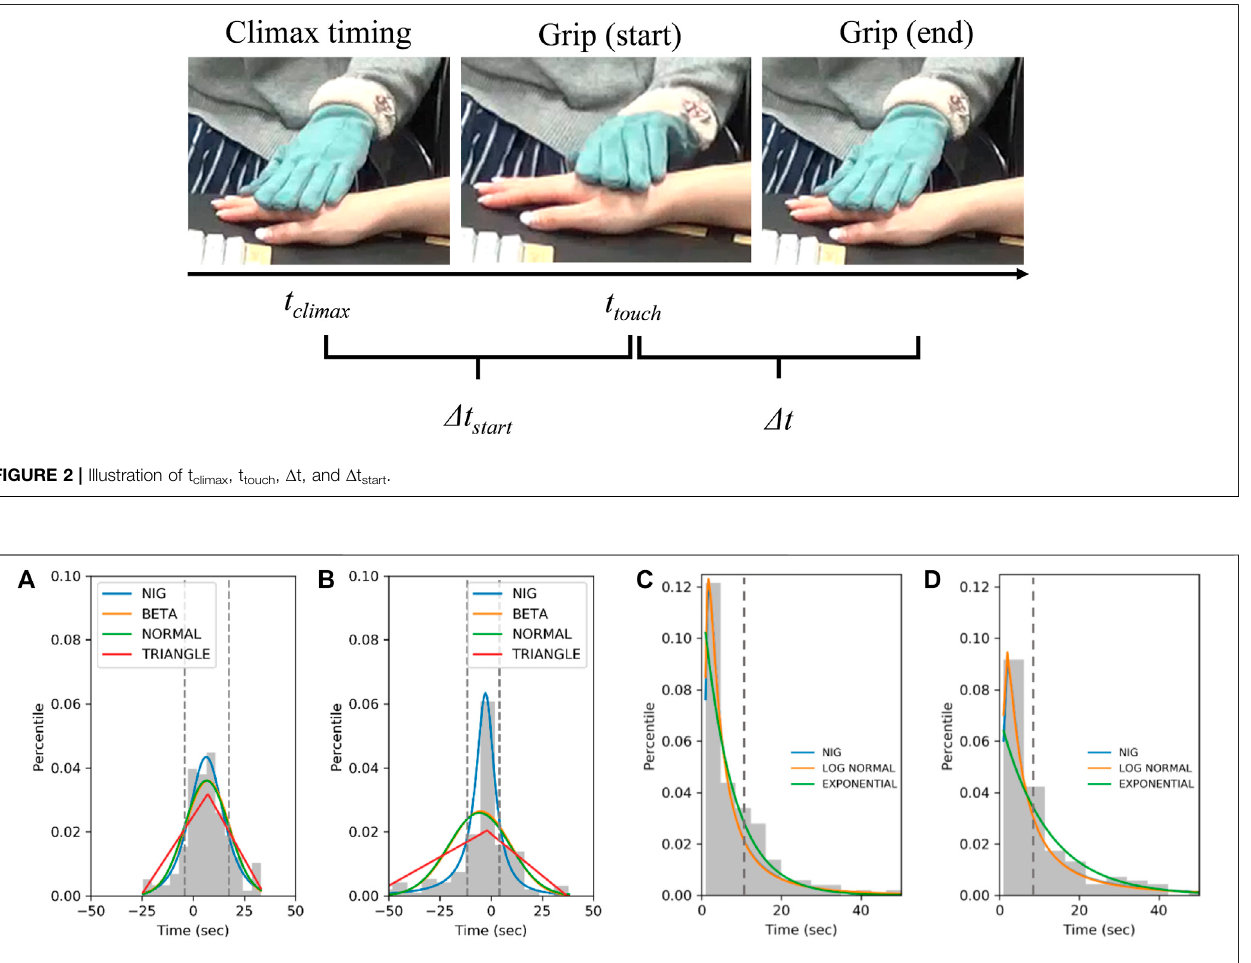
Frontiers in Robotics and AI |